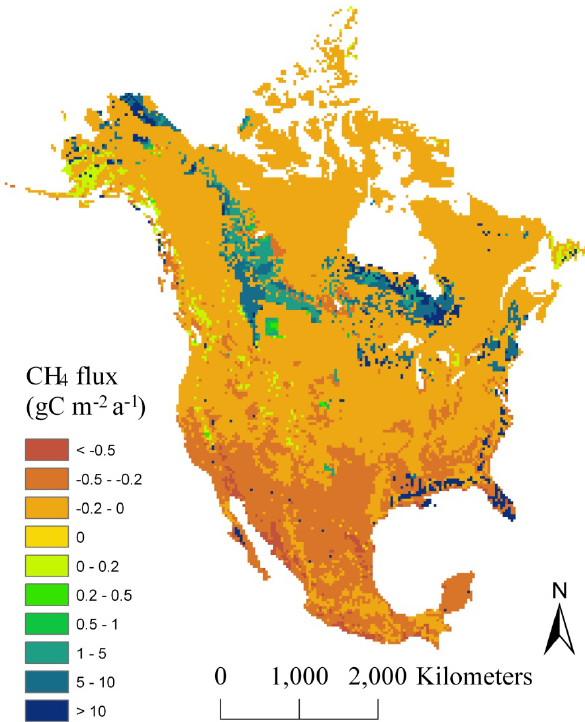
Fig. 3 . Spatial variations of terrestrial CH 4 fluxes caused by global change factors over North America from 1979 to